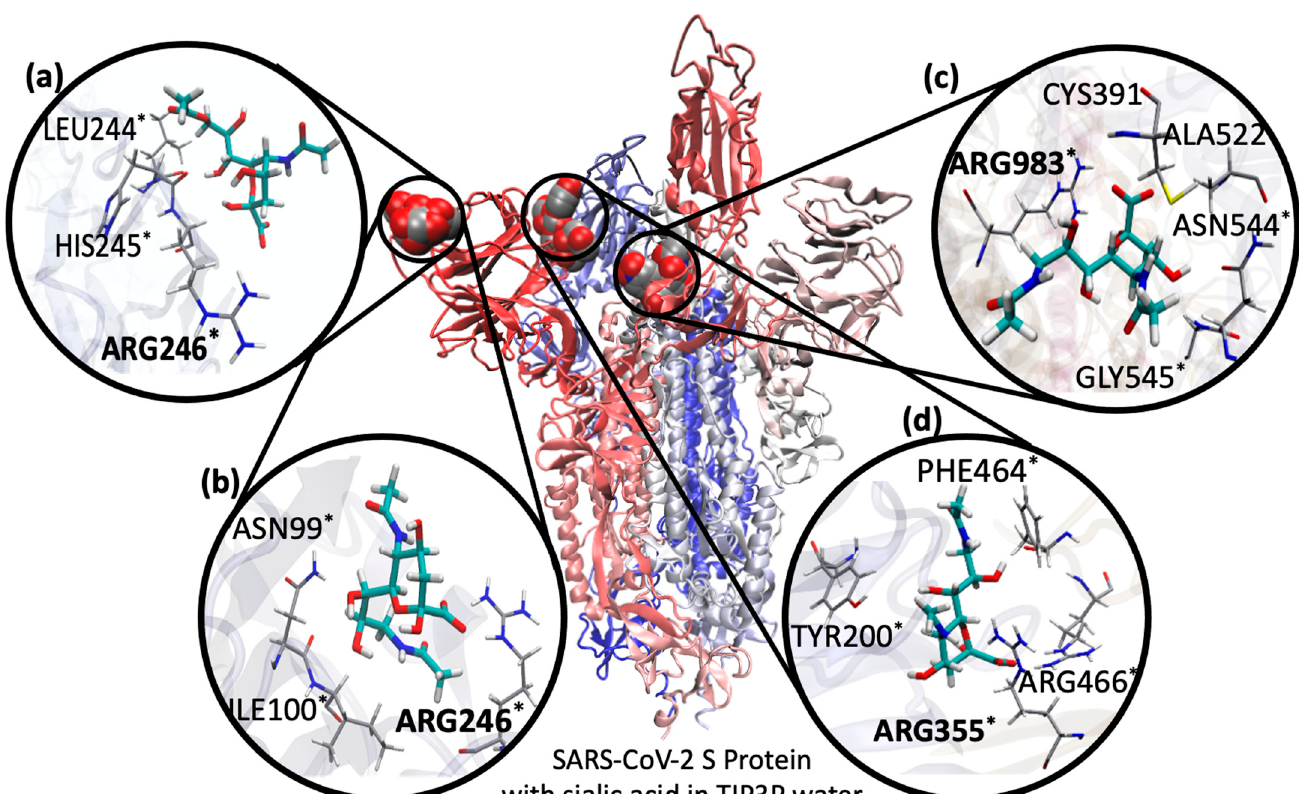
Figure 4. Sia-binding poses with the SARS-CoV-2 S protein. ( a ) Binding pose based on MERS-CoV with Neu5,9Ac 2 highlighted; ( b – d ) binding poses based on initial MD, with Neu5Ac9NAc highlighted. Nearby protein residues are annotated, with top contributor bolded, based on MM-PBSA energy decomposition analysis. * Residues conserved across omicron (PDB ID: 7TB4), kappa (PDB ID: 7VXB), delta (PDB ID: 7W92), gamma (PDB ID: 7M8K), and original (PDB ID: 6VSB) variants of